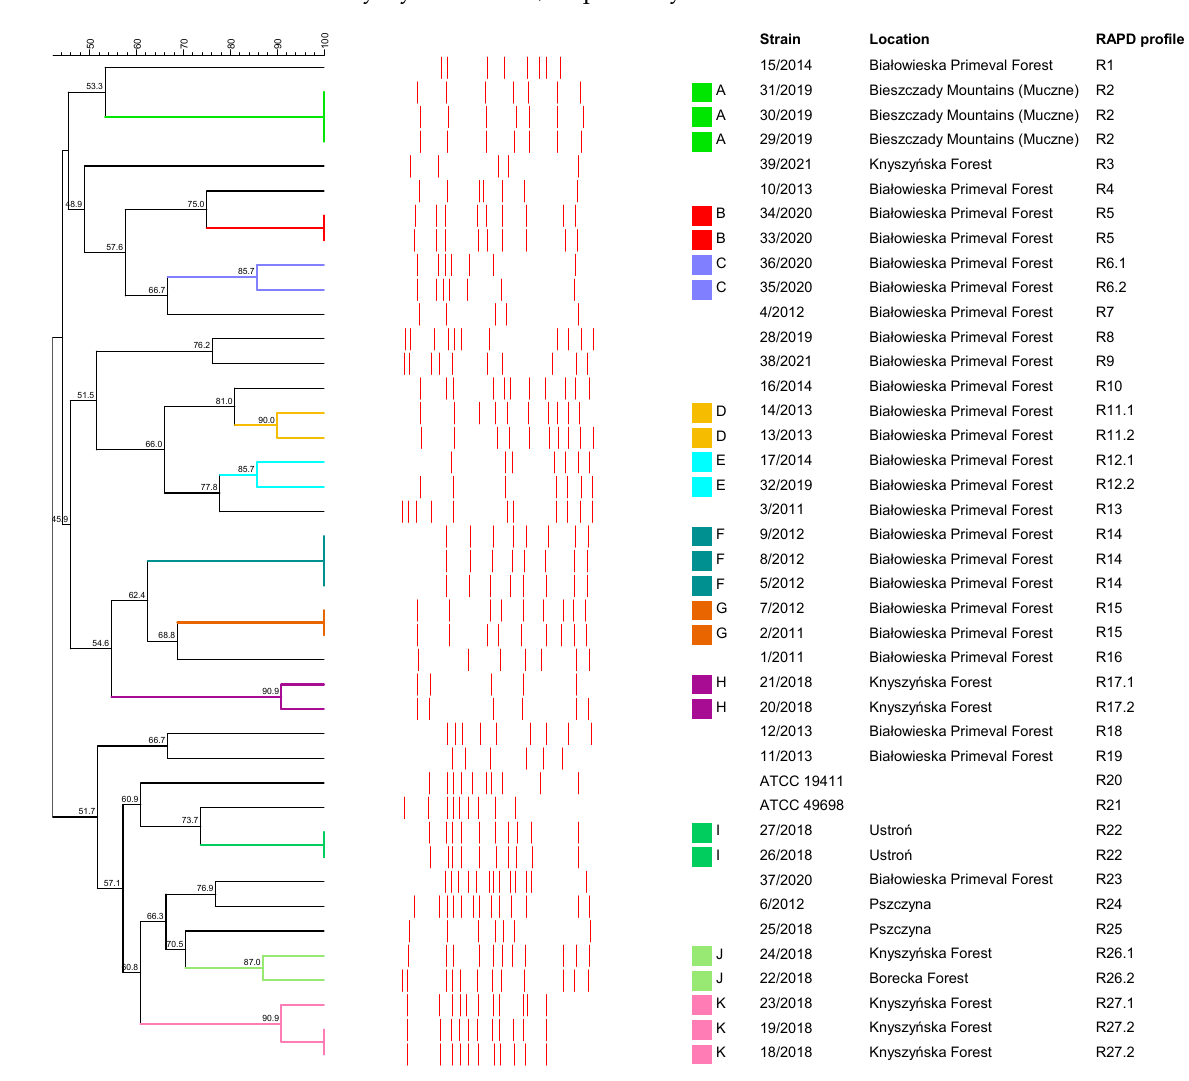
Figure 3. Dendrogram generated on the base of the results of RAPD-PCR typing of 39 T. pyogenes strains isolated from European bison and two T. pyogenes reference strains, using UPGMA analysis and Dice correlation coefficient. RAPD-PCR clusters (A–K) were based on the similarity cut-off of 85%.